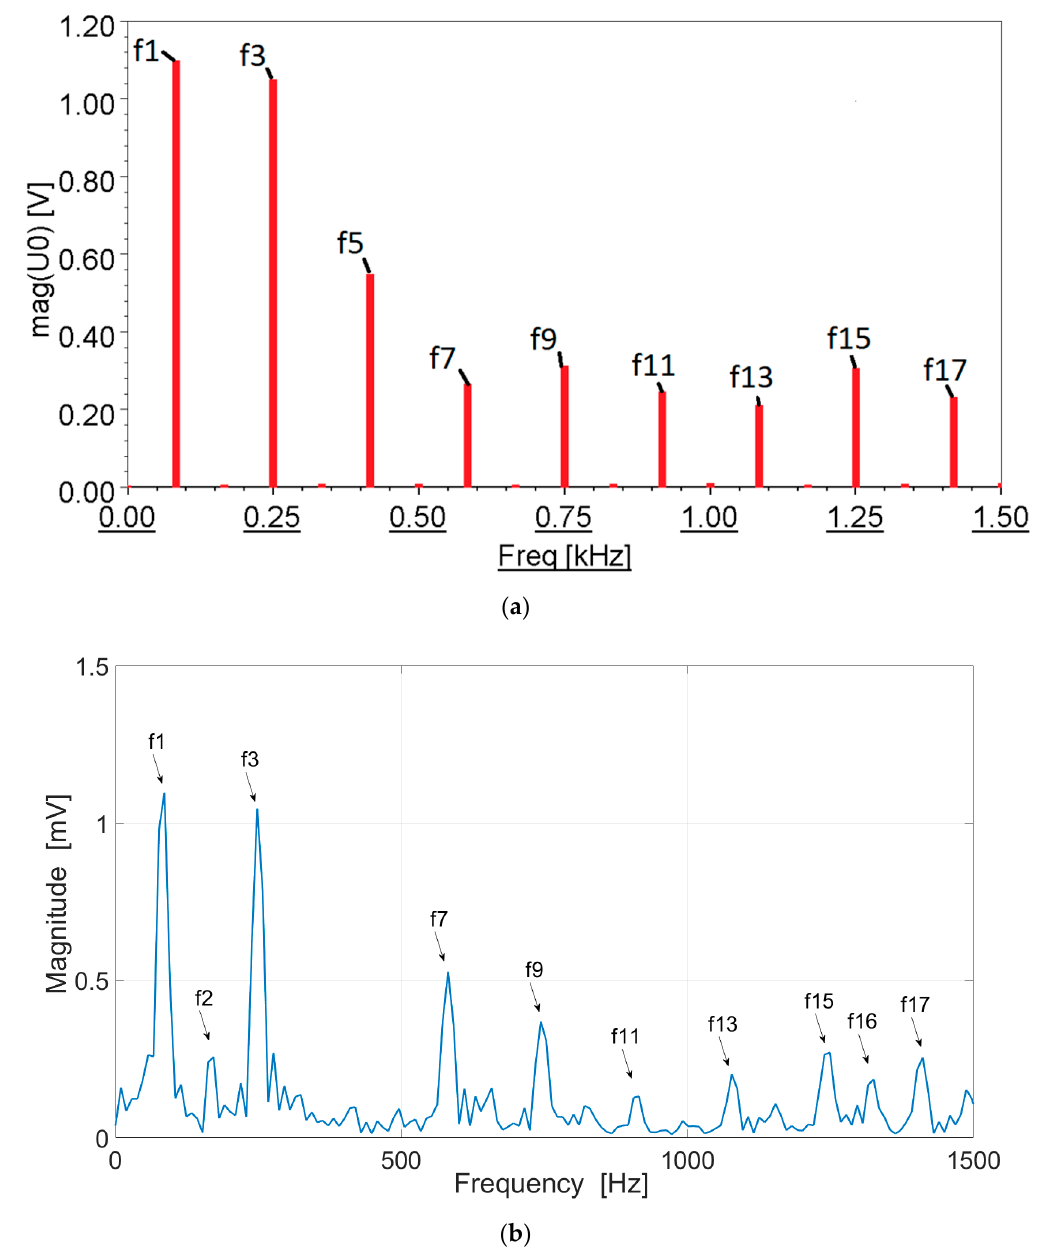
Figure 22. Star–delta (Y ∆ ) configuration—FFT of neutral voltage u 0 in fault state OC1: ( a ) numerical calculations; ( b ) measurements.